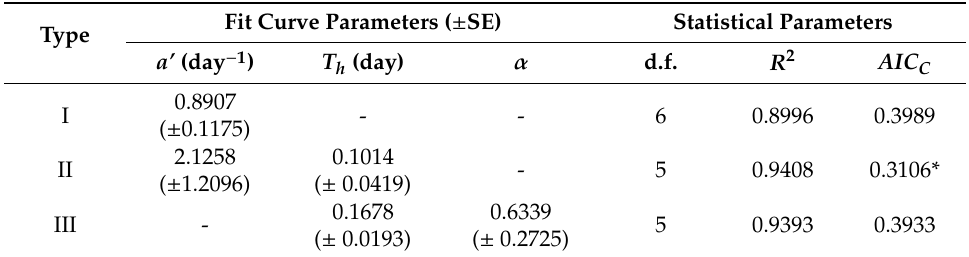
Table 2. Parameters and statistical significance for the functional response equations type I, II, and III when di ff erent densities of Phthorimaeae operculella eggs were exposed to the adult female of Blattisocius tarsalis , for 24 h, under laboratory